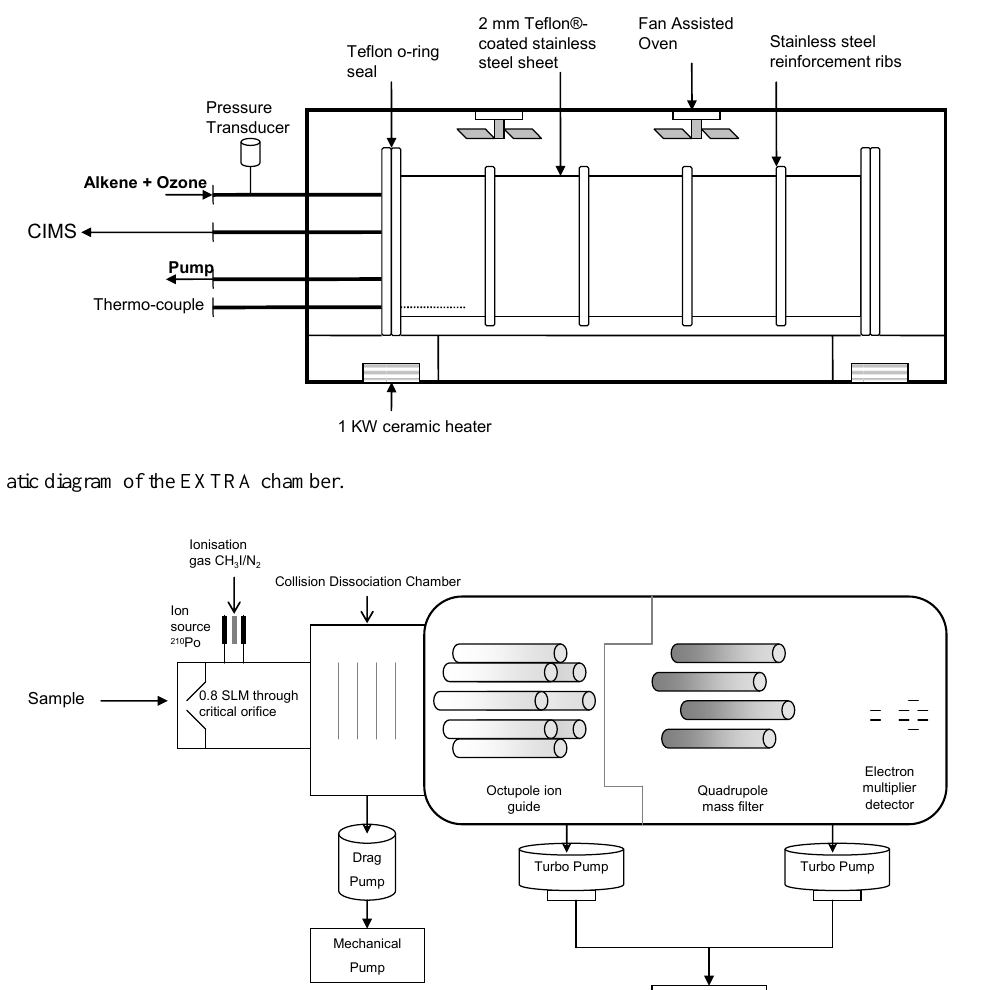
Fig. 2. A schematic diagram of the CIMS